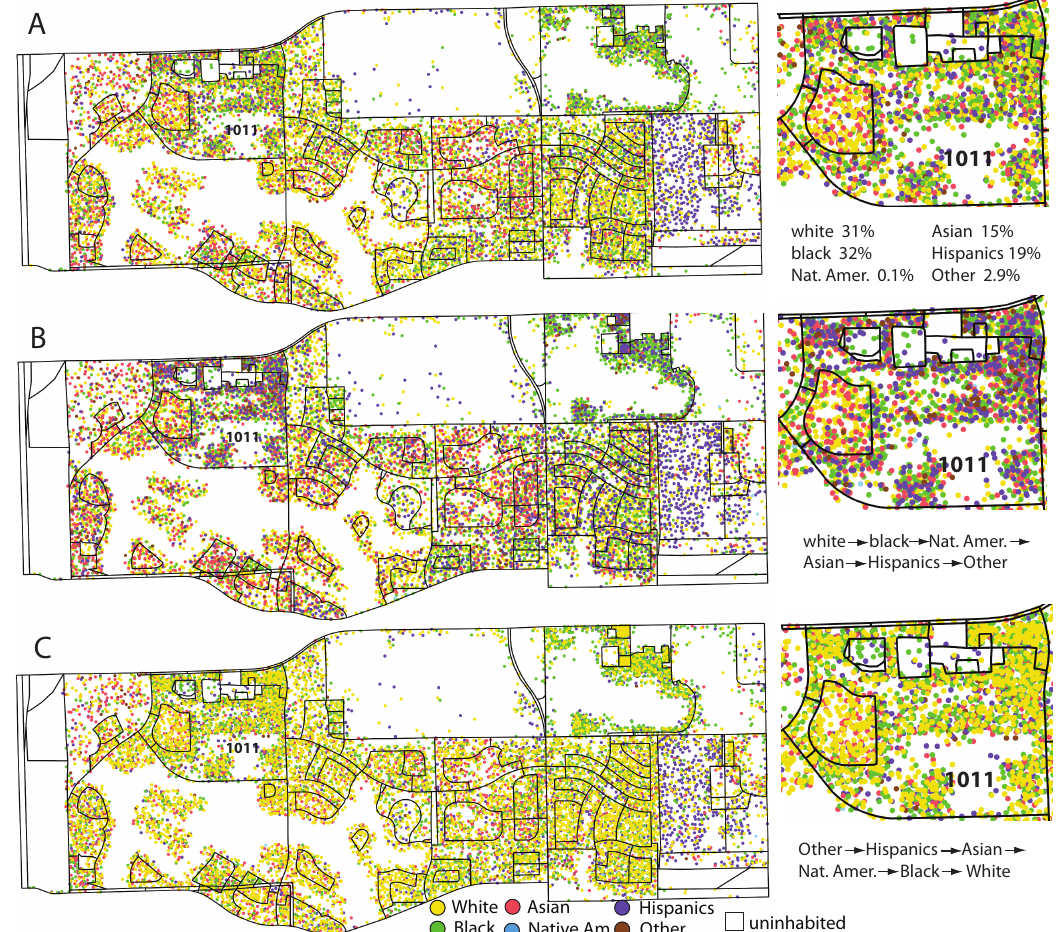
Figure 6. Racial dot maps of Tract 6607.01, Brazoria County, TX, constructed using different protocols of placing dots on the map. ( A ) Dots are placed in random order regardless of the race they represent; ( B ) dots are placed sequentially by the race they represent in an indicated order; ( C ) dots are placed sequentially by the race they represent in a reversed order. Boundaries of Census blocks are indicated by black lines. The left column shows a single block (1011) zoomed in for greater